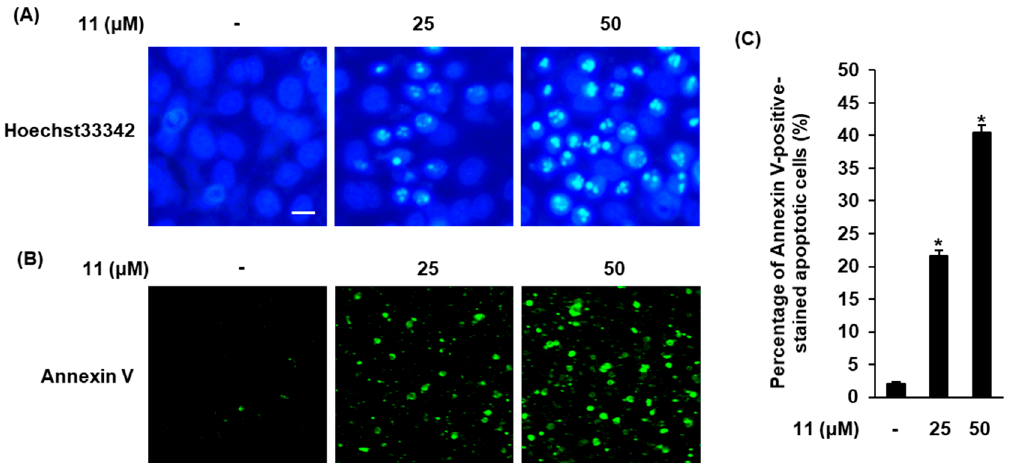
Figure 4. Effects of compound 11 on apoptotic death of A2780 cells. ( A ) Visualization of the condensation of nuclei stained with Hoechst 33342. Scale bar, 50 μ m. ( B ) Visualization of apoptotic cells stained with annexin V (40× magnification). ( C ) Bar graph representing percentage of apoptotic cells. * p < 0.05 compared to the value obtained for non-treated cells. Image-based cytometric assays were done in triplicate and repeated at least three times.